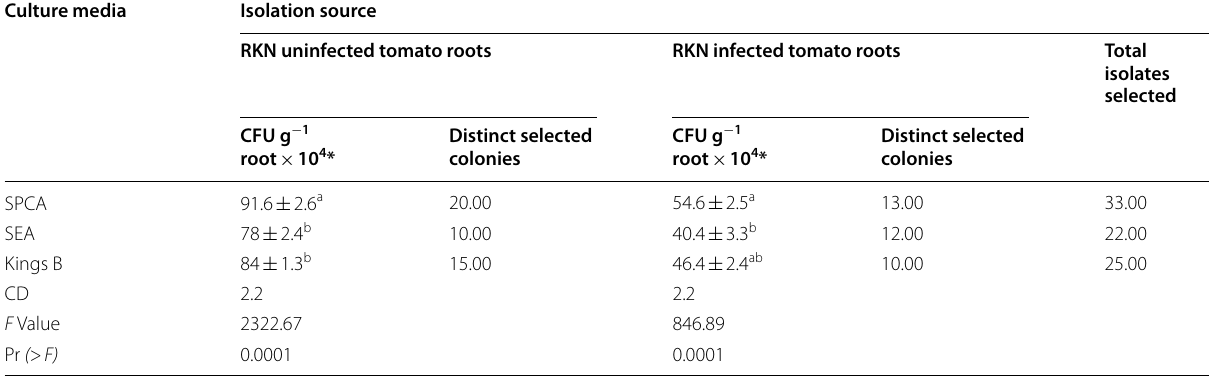
Table 1 Root-associated rhizobacterial densities in root-knot nematode (RKN) infected and uninfected tomato in polyhouse